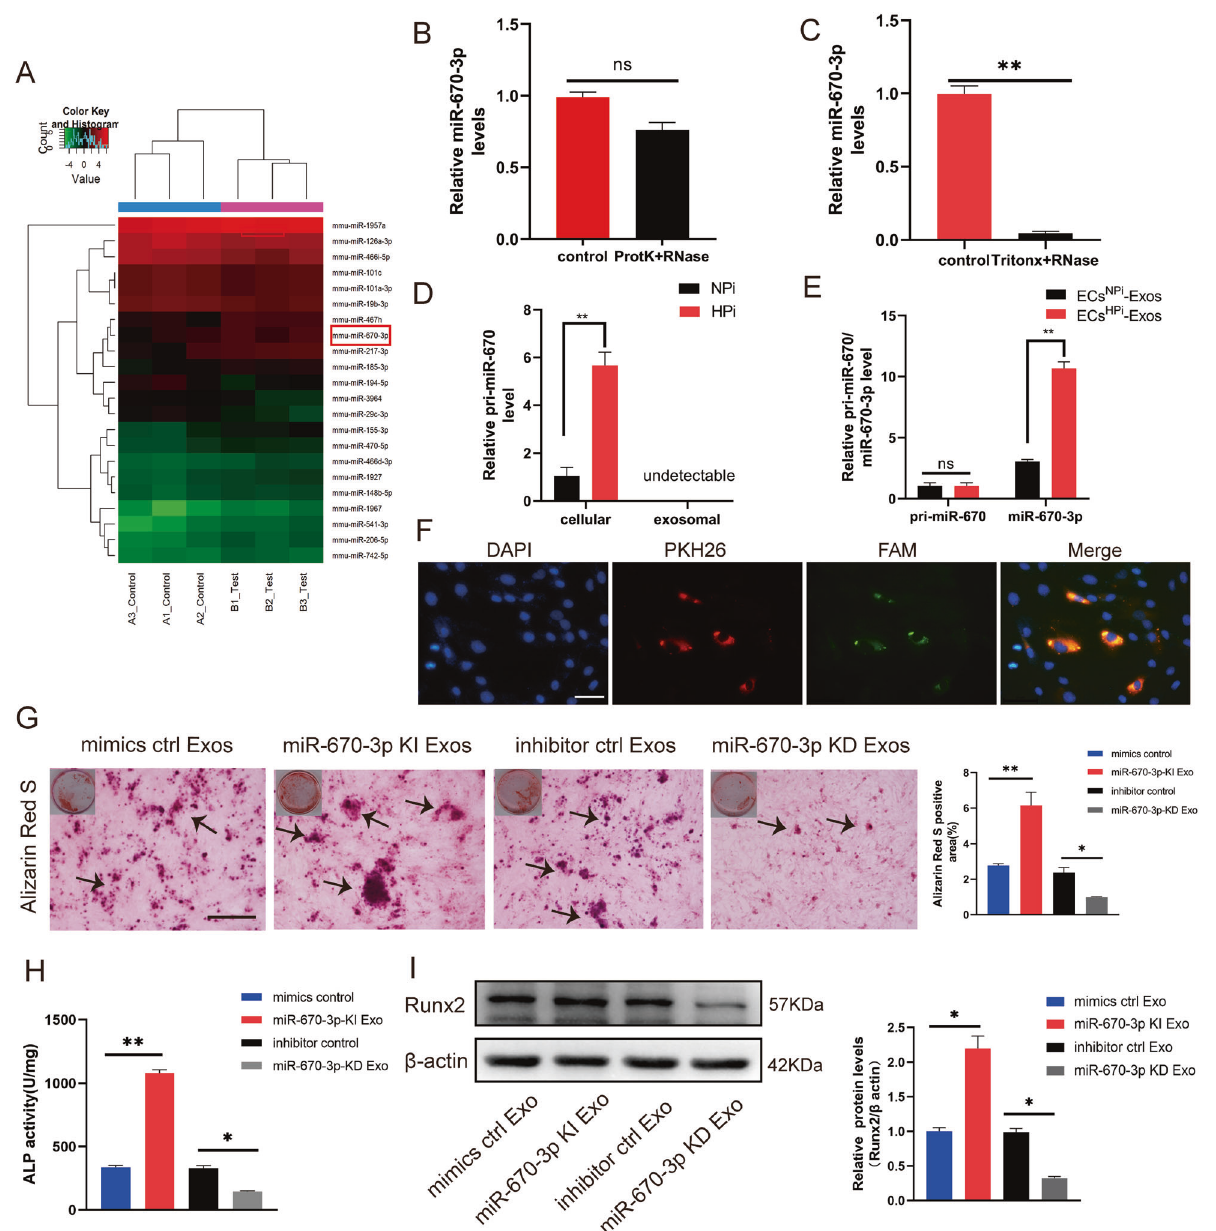
Fig. 3 miR-670-3p was enriched in ECs HPi -Exos and regulated VSMCs calci fi cation. A The differentially expressed miRNAs (a cut-off of absolute fold change ≥ 1.5 and p < 0.05) between ECs NPi -Exos and ECs HPi -Exos according to microarray analysis. B qRT-PCR quantitative results of miRNA after exosomes were treated with proteinase K and RNase. C qRT-PCR quantitative results of miRNA after exosomes were treated with Tritonx-100 and RNase. D Expression levels of pri- miR-670-3p in ECs and EC-Exos. E Expression levels of pri-miR-670-3p and mature